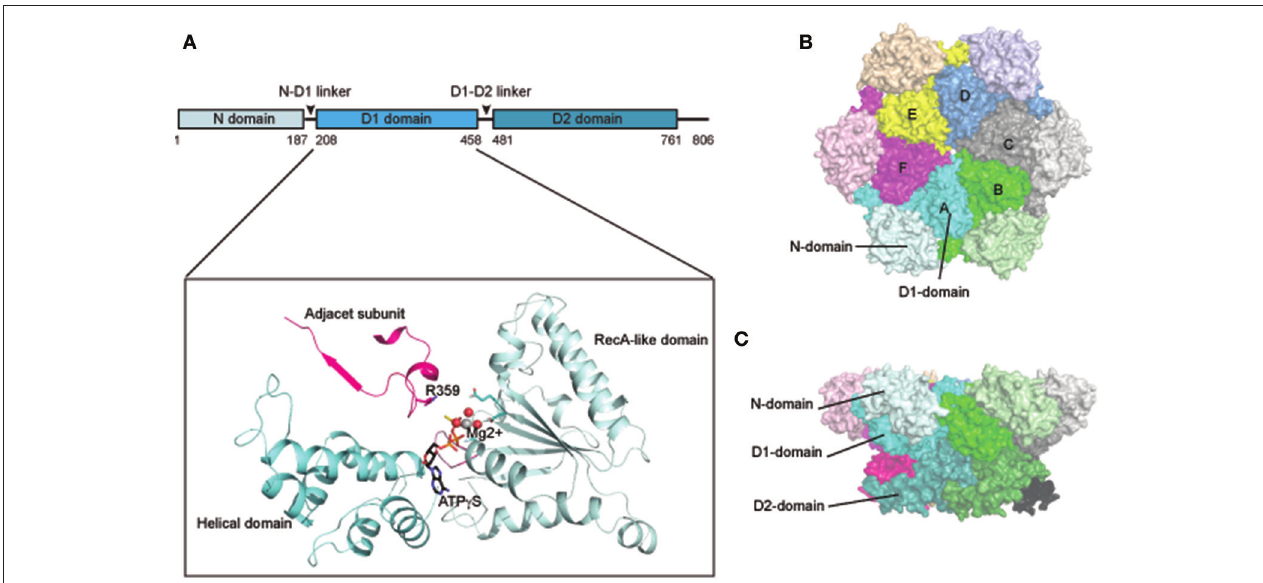
FIGURE 1 | Structure of p97/Cdc48. (A) Cartoon representation of the domain organization of p97/Cdc48. Color code reflects that for subunit A in (B,C) . The ribbon structure shows the D1 domain of a single protomer bound by a ATP γ S molecule (PDB:4KO8). The RecA-like domain is colored in light blue and the characteristic helical domain is in cyan. The nucleotide-binding site communicates with a neighboring subunit through the SRH (second region of homology, in red) motif, where a conserved Arg-finger residue R359 is in contact with the bound nucleotide. (B,C) Surface representation of the structure of hexameric p97 (PDB: 3CF2 in the ADP-bound form) (B) is a top view down the 6-fold symmetry axis showing the N-D1 ring. The six subunits are labeled in colors. The D1 domain and the N-domain are indicated with arrows and labeled for one of the six subunits. (C) is a side view of the p97 hexamer.